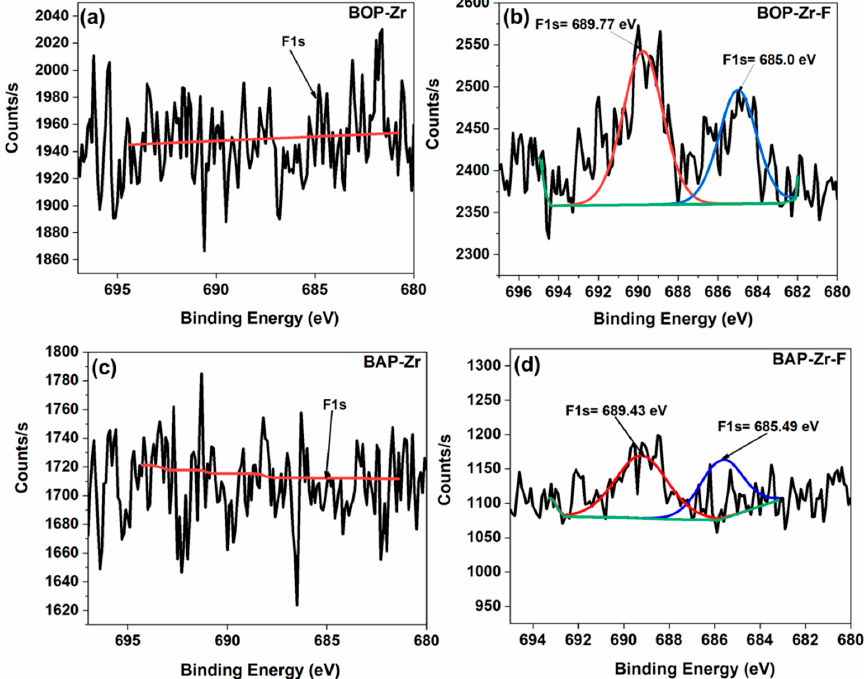
Figure 11. Deconvoluted XPS spectra for Zr 3d, ( a ) BOP-Zr, ( b ) BOP-Zr-F, ( c ) BAP-Zr, and ( d ) BAP-Zr-F.